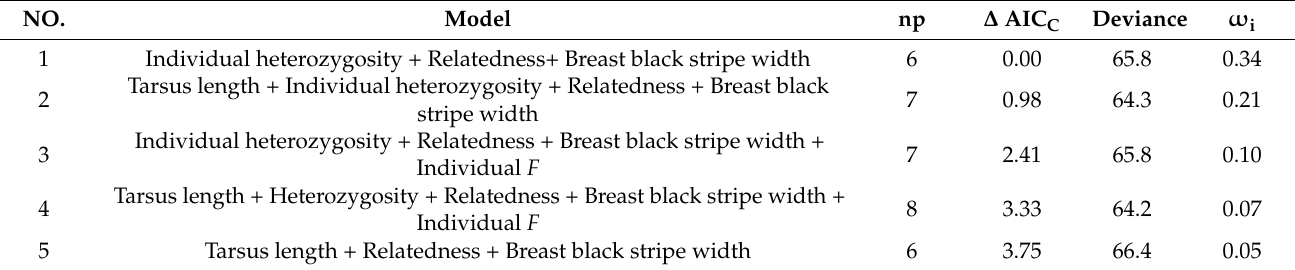
Table 4. Selection of the GLMMs for predicting pairing status of male great tits in double breeding in relation to individual F , individual heterozygosity, breast black stripe width, tarsus length, and repertoire size: the number of estimated parameters (np), model deviance, difference in AICc between the current and the best model ( ∆ AICc), and AICc weights ( ω i ) are given for each model.